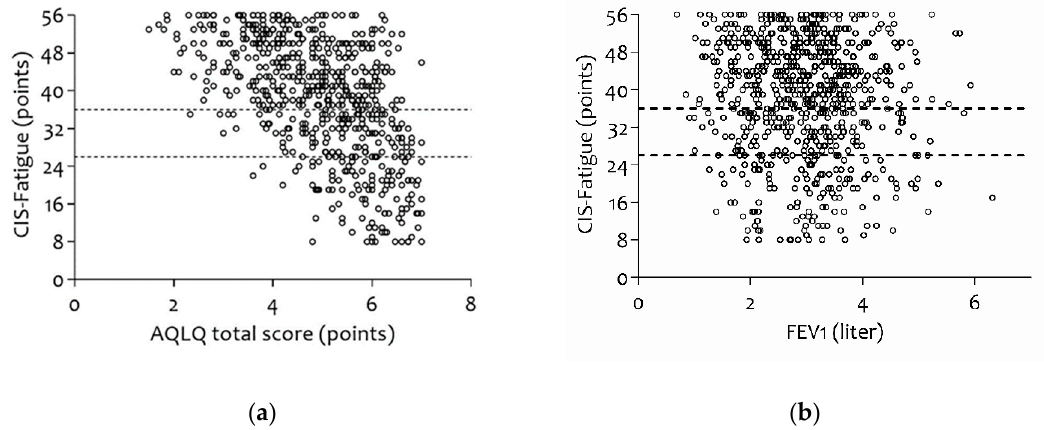
Figure 4. ( a ) Correlation between fatigue and asthma-related quality of life ( ρ = − 0.554, p < 0.001) and ( b ) absence of correlation between fatigue and FEV1 ( ρ = − 0.083, p = 0.025). AQLQ: Asthma Quality of Life Questionnaire; CIS-Fatigue: Checklist Individual Strength-Fatigue; and FEV1: Forced Expiratory Volume in the first second.